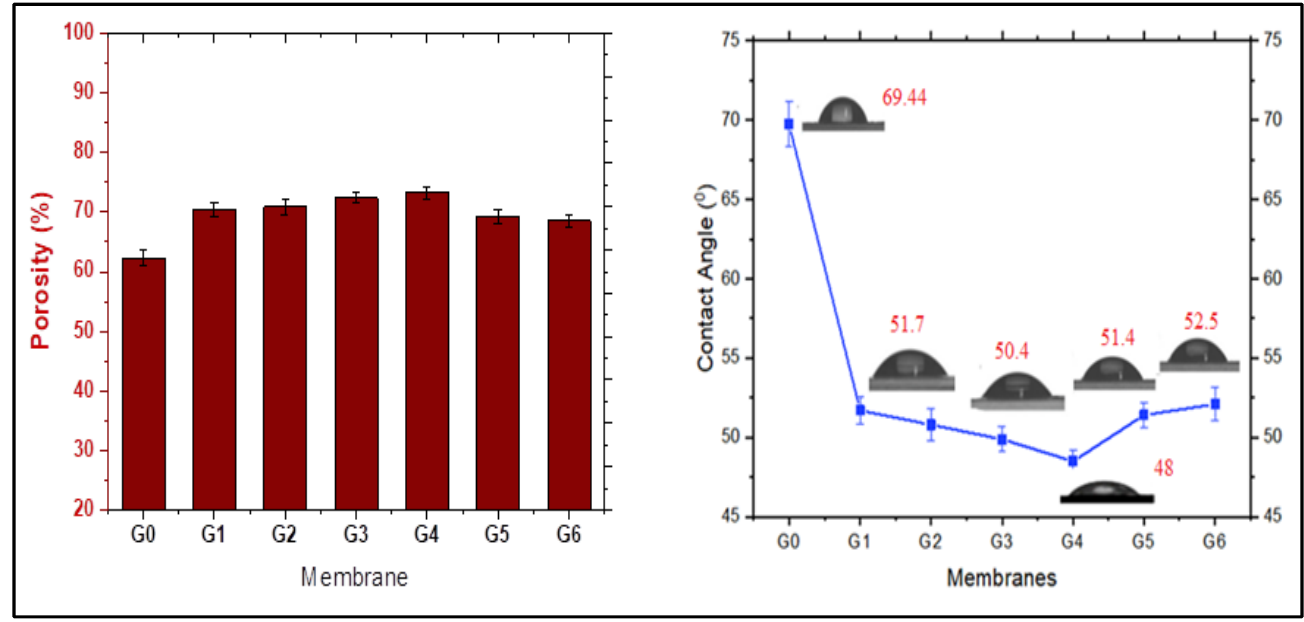
Figure 8. ( Left ) the effects of TGF content on the porosity of PES/TGF blend membranes; ( Right ) contact angle of PES membranes with various TGF concentrations. contact angle of PES membranes with various TGF